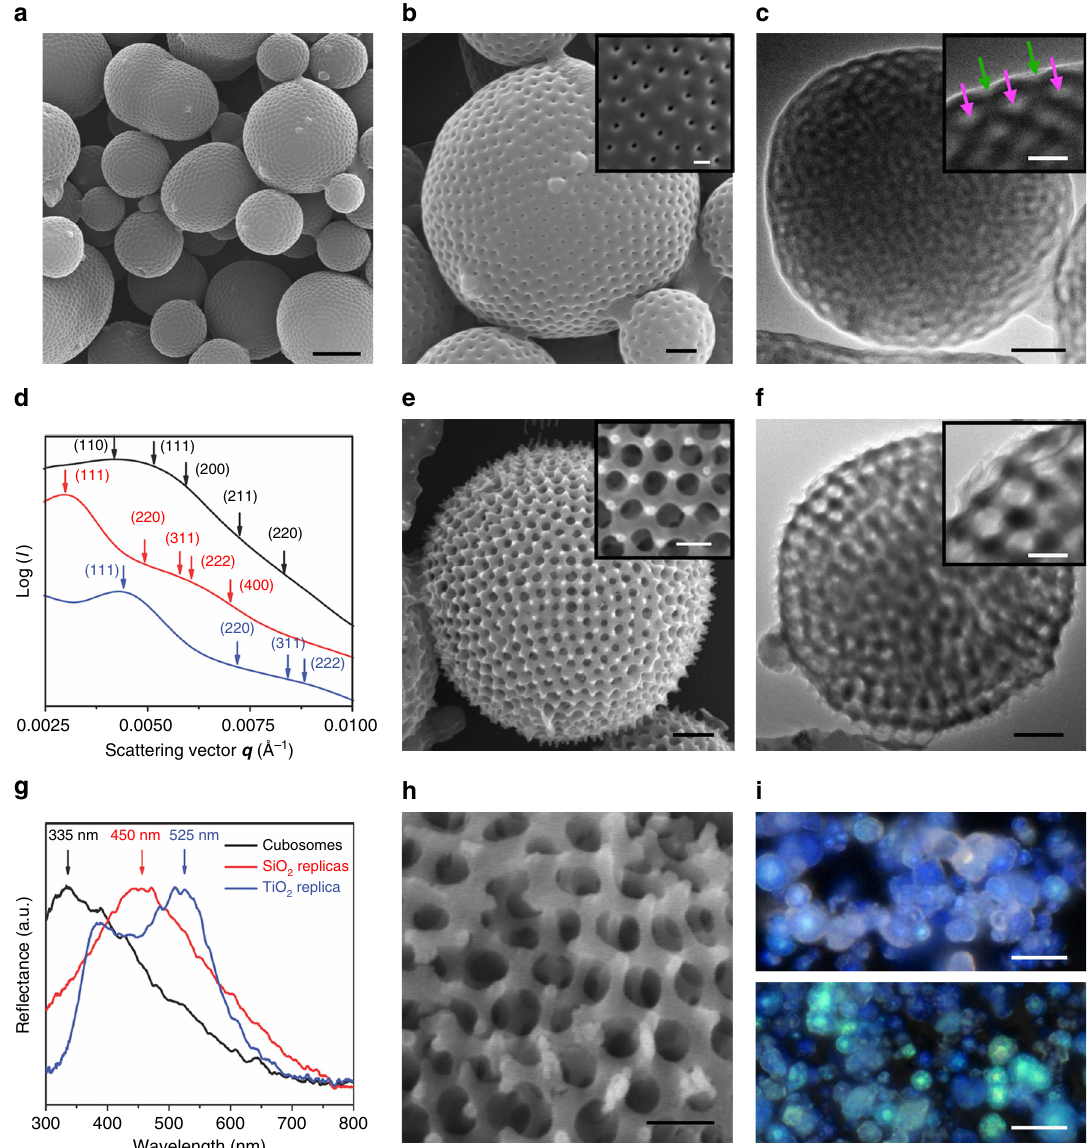
Fig. 4 PCs and cubic crystalline single networks having large lattice parameters. a , b SEM images of PCs of PEG2000 3 -PS 2140 display the large pore distance at the surface. Scale bars are 2 μ m ( a ), 500 nm and 200 nm ( b and inset). c TEM image of the PC exhibited the distance of two pores at the surface is 240 nm. The open and closed channels are marked by green and magenta arrows, respectively. Scale bars are 500 nm and 200 nm (the inset). d SAXS results of the PCs (black line, assigned by assuming Pn (cid:1) 3 m symmetry, a = 213 nm) and single networks of silica (red, assigned to Fd (cid:1) 3 m , a = 361 nm) and titania (blue, assigned to Fd (cid:1) 3 m , a = 247 nm). e , f SEM and TEM images of silica single cubic networks templated by PCs of PEG2000 3 -PS 2140 . Scale bars are 500 nm and 200 nm (insets). g UV – vis re fl ectance spectrometry of the PCs (black), silica networks (red), and titania networks (blue). h SEM image of fractured titania single cubic network showing internal Fd (cid:1) 3 m symmetry. Scale bar is 200 nm. i Optical microscope images of silica (top) and titania (bottom) networks. Scale bars are 10 μ